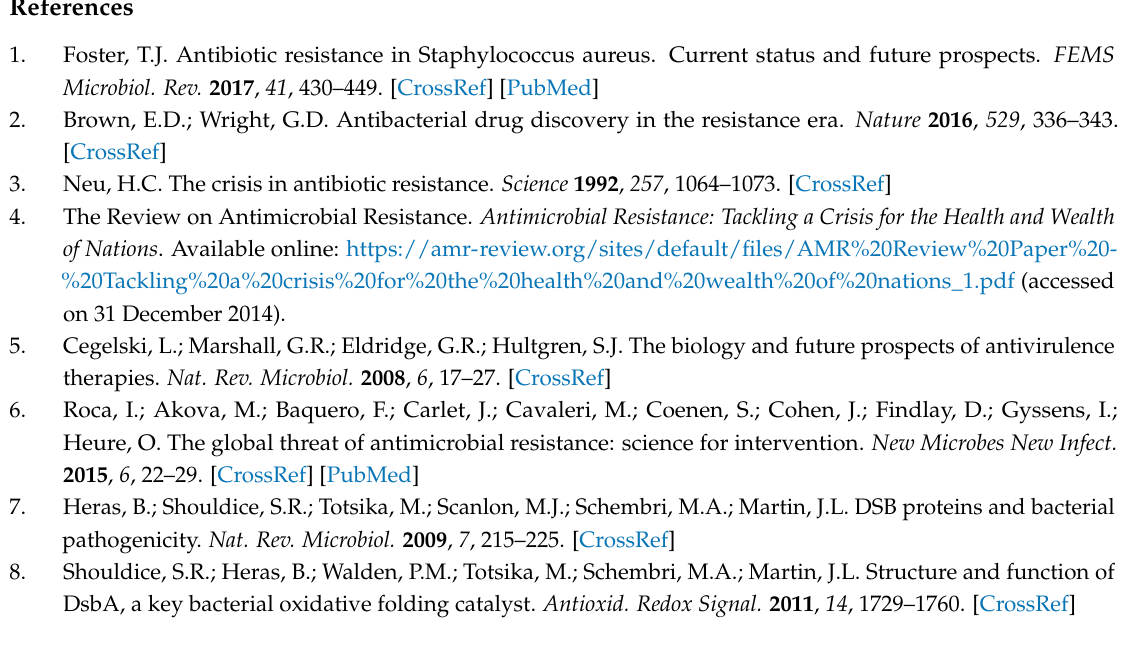
Table S1: Patchdock and ClusPro Cluster scores of native and mutated DsbA signal